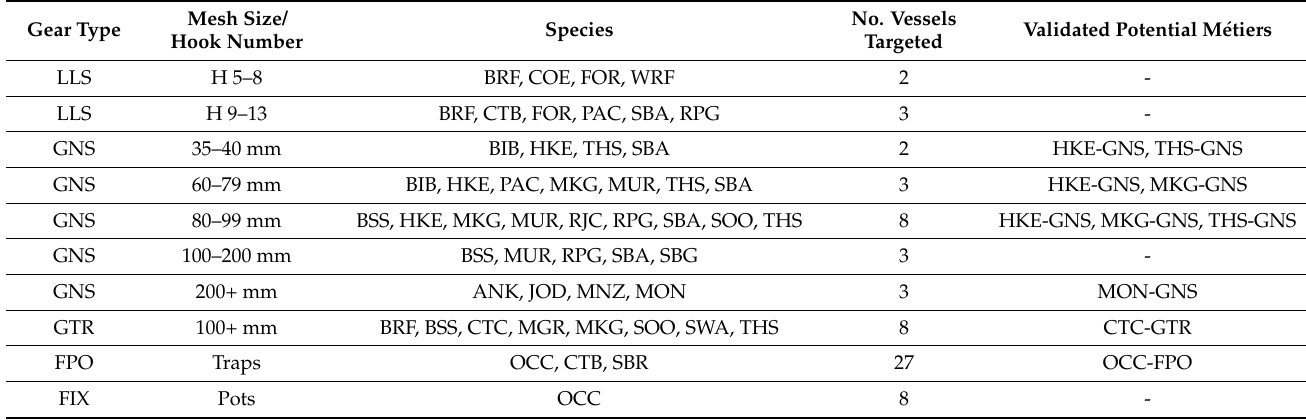
Table 2. Gear type with mesh size or hook number, the targeted species and the number of vessels op- erating with the m é tier and the validated potential m é tiers [FAO Code: ANK = blackbelly angler; BIB = pouting; BRF = blackbelly rosefish; BSS = European seabass; COE = conger eel; CTB = common Two- banded seabream; CTC = cuttlefish; FOR = forkbeard; HKE = hake; JOD = john dory; MGR = meagre; MKG = thickback sole; MON = monkfish; MNZ = Lophius spp, MUR = red mullet; OCC = octopus; PAC = common pandora; RJC = thornback ray; RPG = red porgy; THS = bastard soles; SBA = axillary seabream; SBG = gilthead seabream; SBR = blackspot seabream; SOO = sole; SWA = white seabream; WRF = wreckfish].